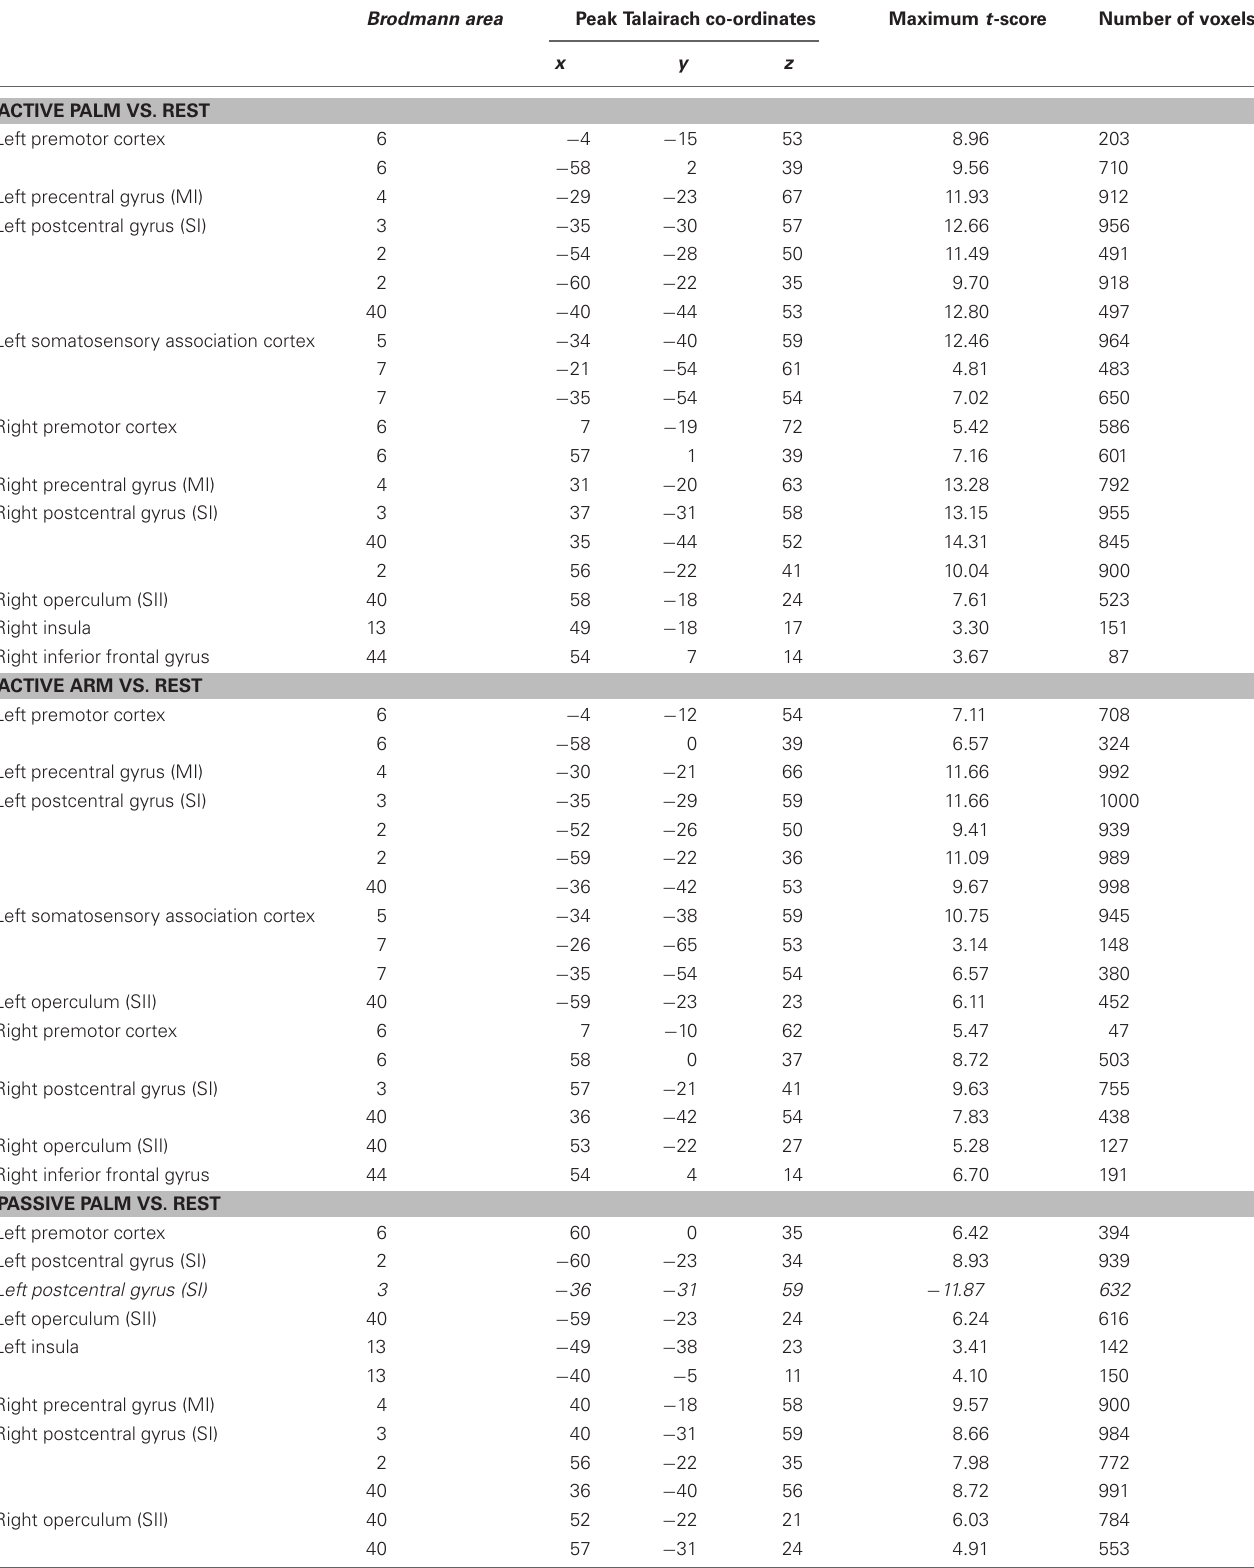
Table 1 | Overview of all the cortical regions showing significant differences from the resting baseline for each touch conditions. Brodmann area Peak Talairach co-ordinates Maximum t -score Number of voxels x y z ACTIVE PALM VS. REST Left premotor cortex